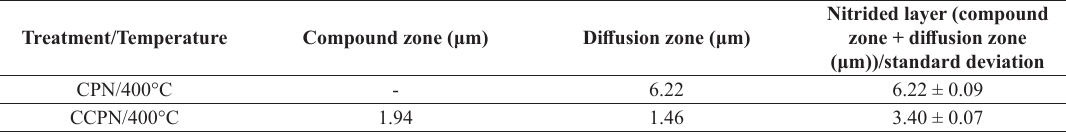
Table 5. Average thickness of the nitrited layers, CPN and